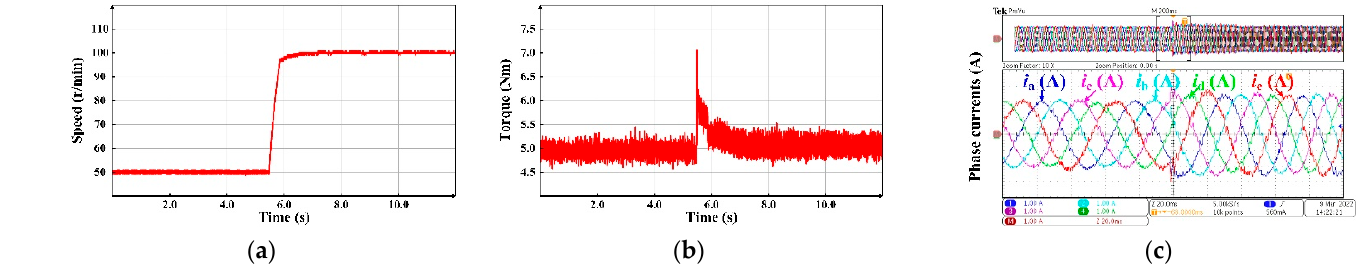
Figure 6. Normal operation experiment with the impulse current PWM technique and SDFT-LPF: ( a ) speed; ( b ) torque; ( c ) phase currents.